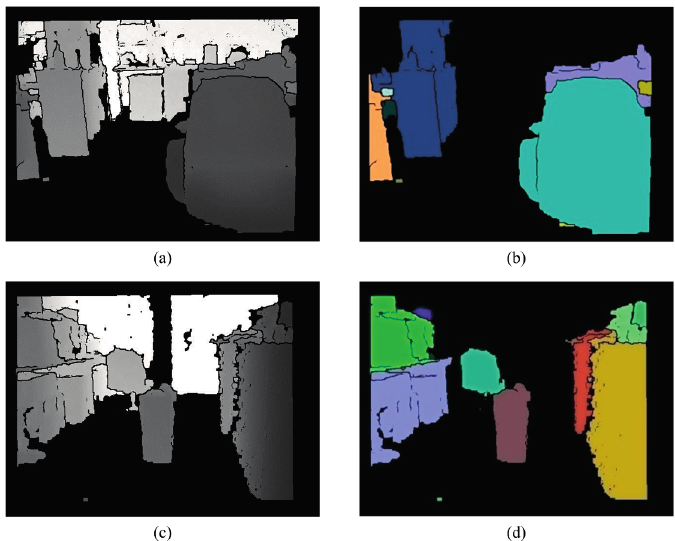
Figure 15. Labeling. ( a ) Ground removed image; ( b ) Labeling result; ( c ) Ground removed image; ( d ) Labeling